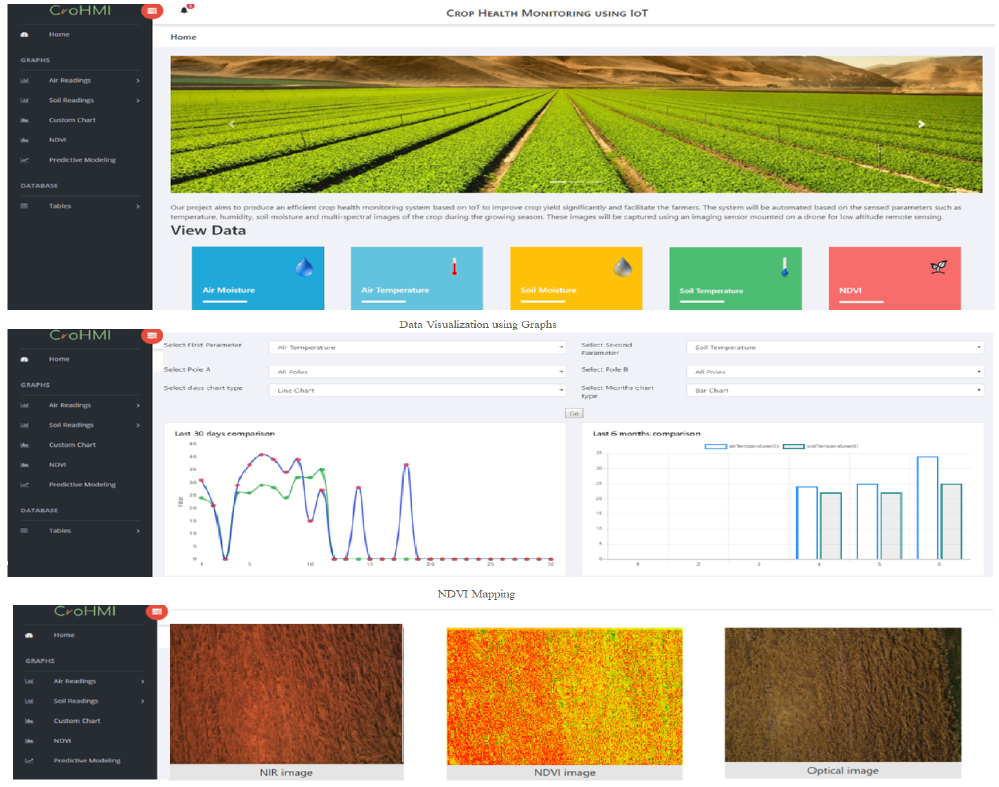
Figure 2. User interface of the web portal.